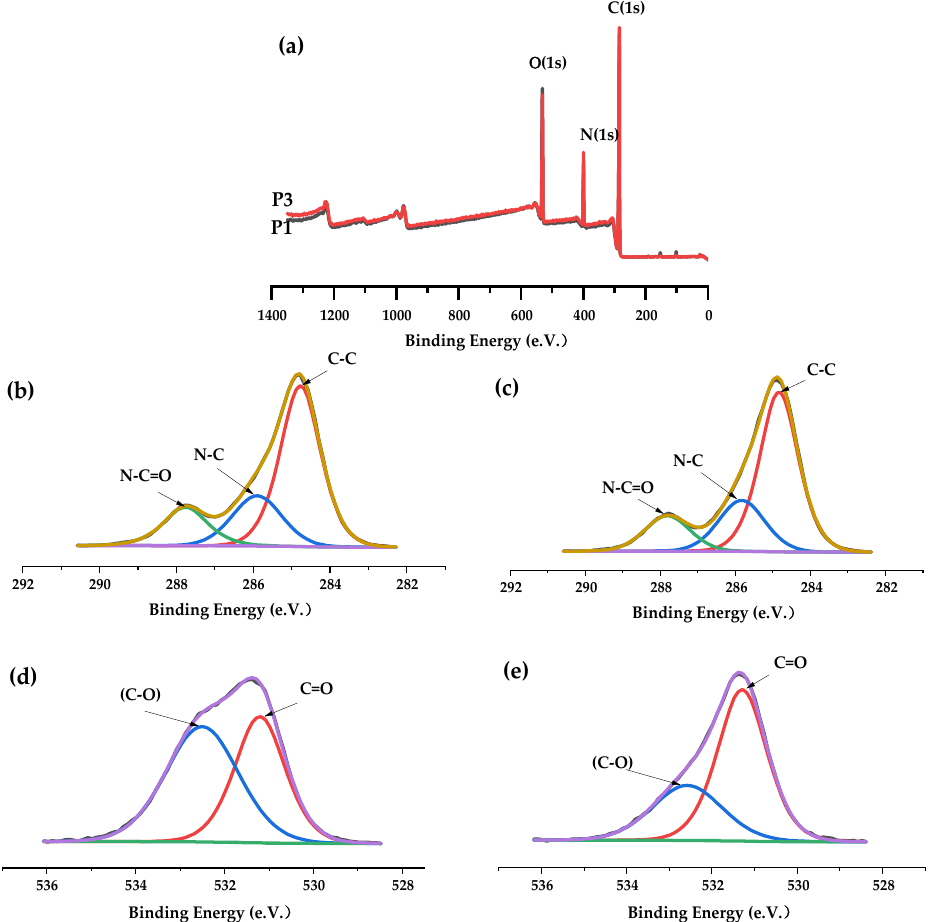
Figure 1. ( a ): XPS full-scan spectra of P1 and P3 membrane; ( b , c ): C1s spectra of P1 and P3 membrane; ( d , e ): O1s spectra of P1 and P3 membrane. Table 2. Elemental composition by atomic percent of different kinds of PA66 membranes.